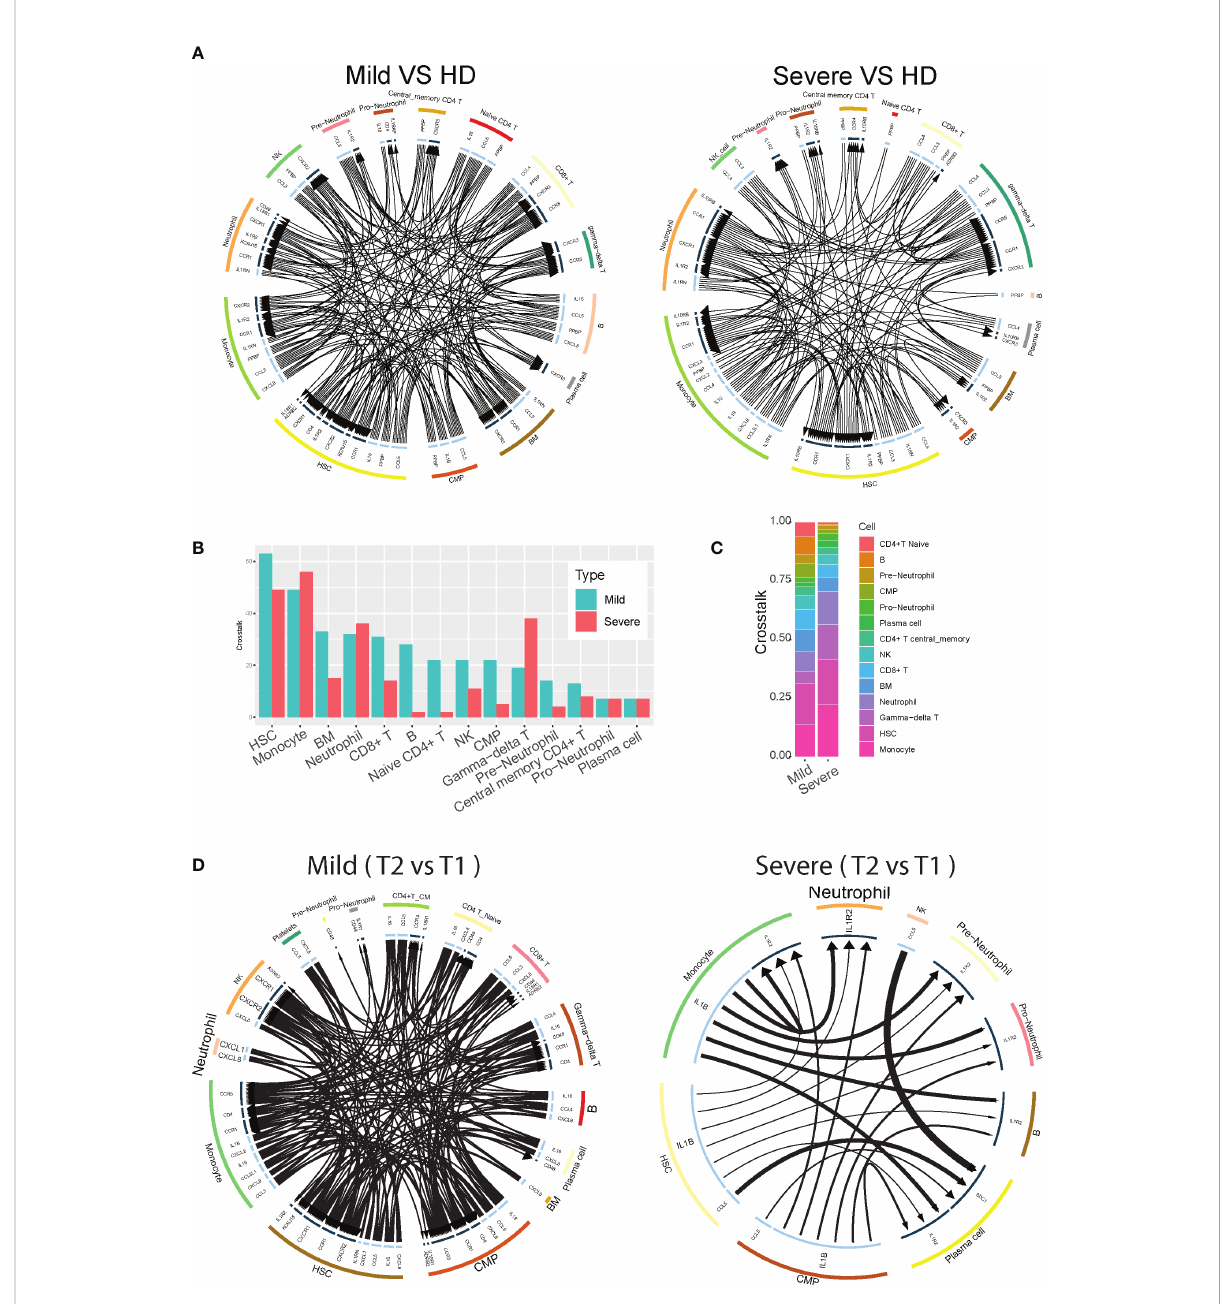
FIGURE 3 Neutrophil cell-cell interactions become progressively dysregulated in patients with severe COVID-19. (A) Circos plot showing the up-regulated cellular crosstalk mediated by signi fi cantly (adjusted P-value <0.05) up-regulated ligand-receptor pairs between in fl ammation-related cell types from mild or severe COVID19 patients compared with that from healthy controls. (B) Count of the up-regulated cellular crosstalk for every cell type in mild and severe COVID19 patients, respectively. (C) Composition of the up-regulated cellular crosstalk in mild and severe COVID19 patients, respectively. (D) Circos plot showing the cellular crosstalk mediated by up-regulated (2nd timepoint versus 1st timepoint, or T2 vs T1) ligand-receptor pairs between in fl ammation-related cell types from recovered mild (left) and deceased severe (right) COVID19 patients,